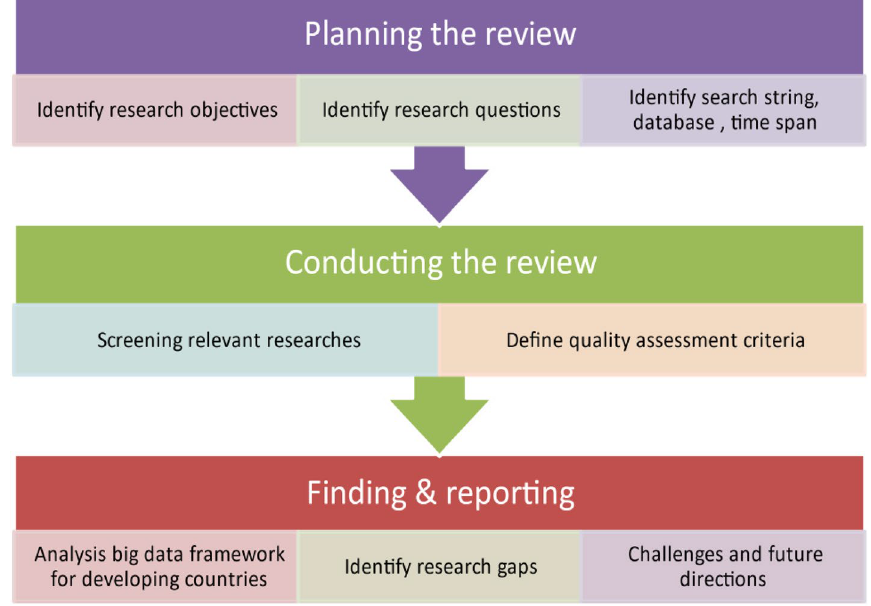
Fig. 2 The adopted SLR